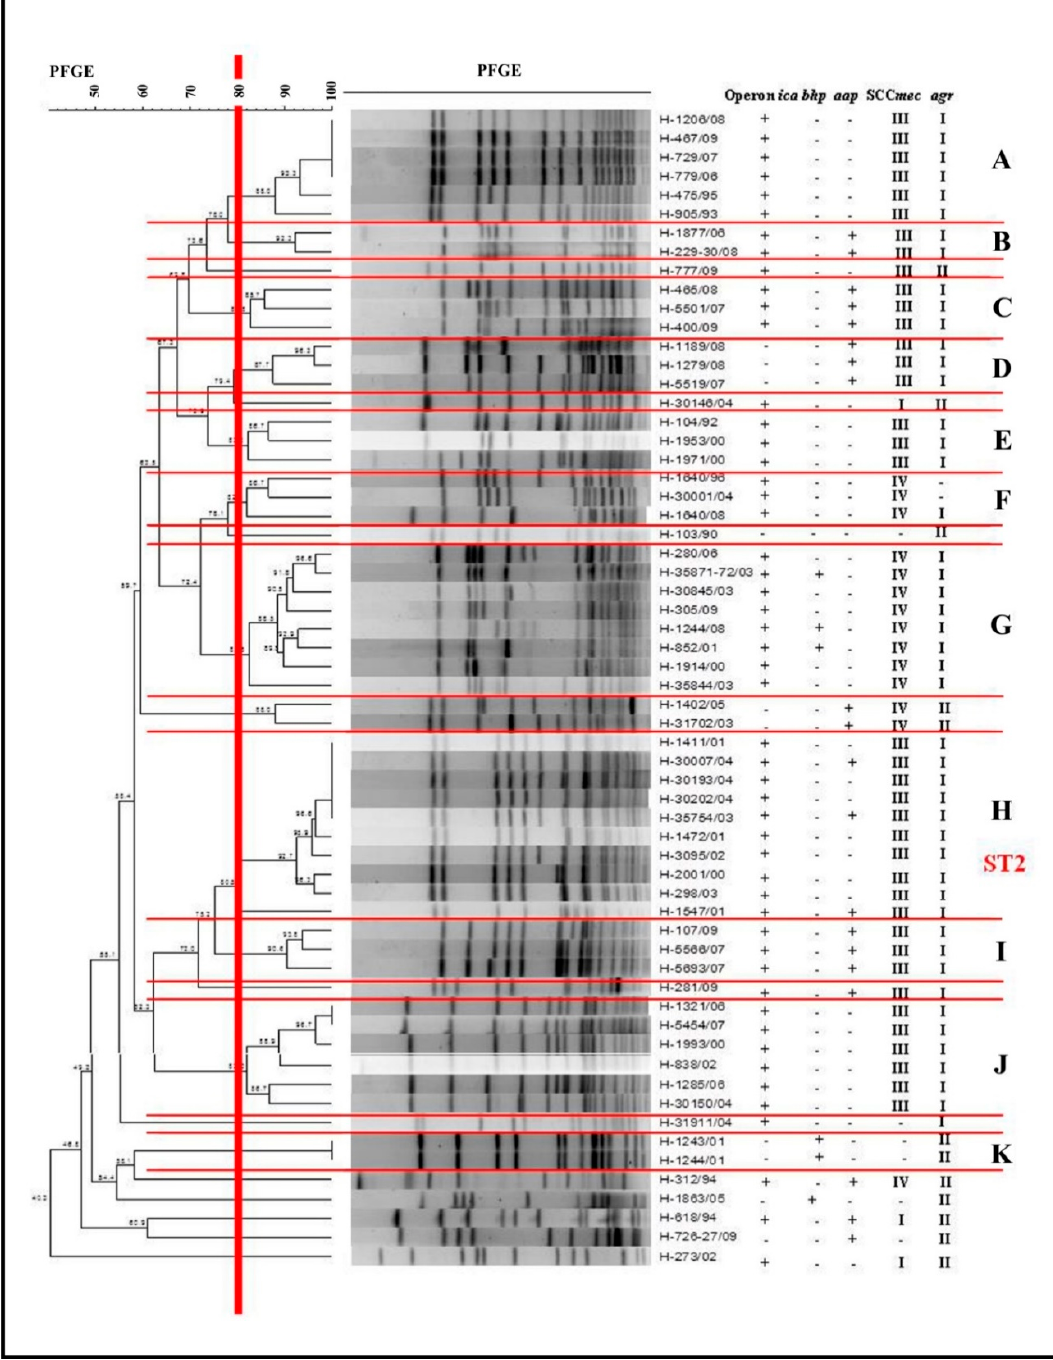
Figure 2. Dendrogram generated by the Dice/UPGMA (Bionumerics Applied Maths) analysis of Staphylococcus epidermidis biofilm producers isolated from 1990 to 2009, indicating the presence (+) or absence of ( − ) operon ica expression, bhp and aap genes, and carrying of the SCC mec and accessory gene regulator ( agr) locus.